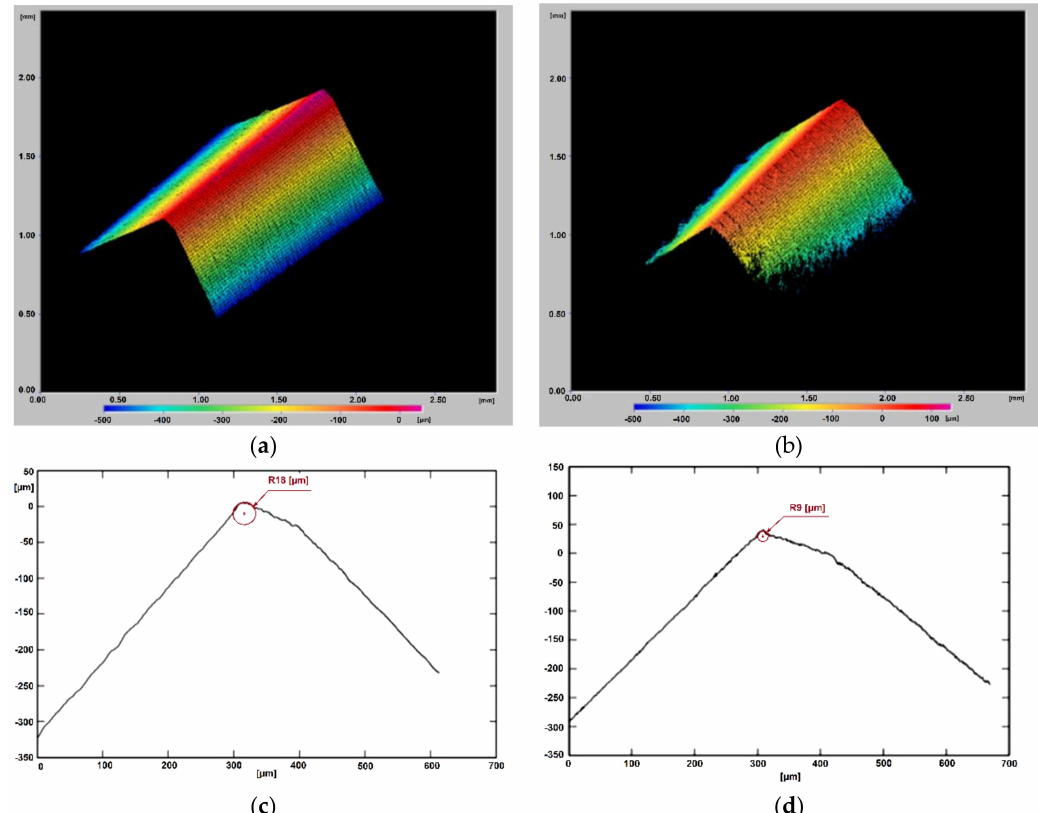
Figure 8. The radius of curvature of the cutting edge ( R ) of the insert made from the Al 2 O 3 + SiC ceramic: ( a ) The three-dimensional (3D) model of the cutting edge before coating; ( b ) The 3D model of the cutting edge after depositing the diamond-like coating; ( c ) The profilogram of the cutting edge before coating; ( d ) The profilogram of the cutting edge after depositing the diamond-like coating.